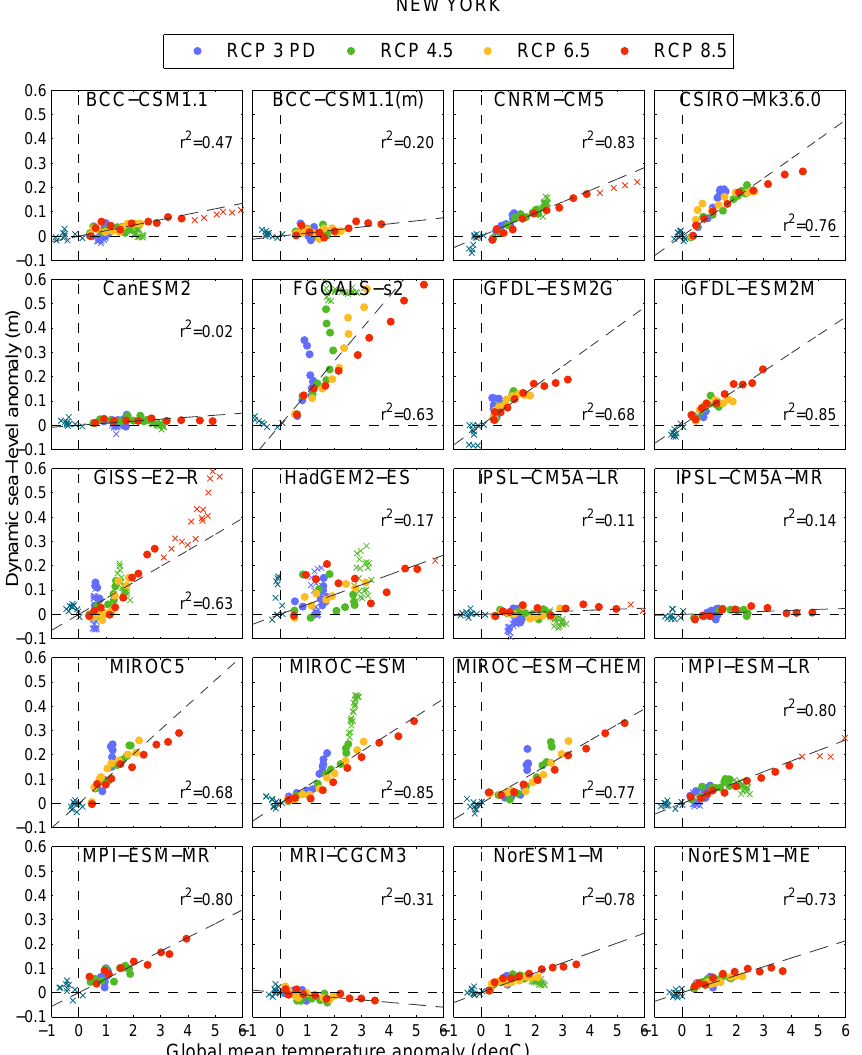
Fig. 2. Scatter plot of dynamic sea level change for New York City against the global mean surface air temperature anomaly (with respect to a 1980–1999 reference period; marker are 10-yr averages). The data represent the historical period (light blue crosses) and the four RCP scenarios (see legend). Stabilization periods (after 2100) are indicated with green crosses. During the stabilization period, the linear relationship between dynamic sea level change and global mean temperature is less robust, but this does not affect our projections towards the end of the 21st century. The dotted line is the linear regression over 2000–2100 based on all combined RCP scenarios, using yearly values. The r 2 score is also indicated on each panel, calculated from decadal averages between 2000 and 2100 (about 40 data points if all RCPs are available). The data are retrieved as the closest model grid cell from the geographical coordinates [40.5 ◦ N, 73.5 ◦